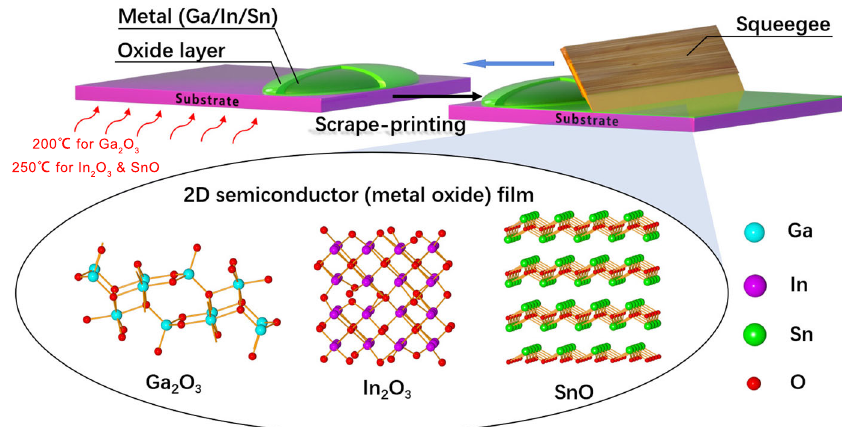
Fig. 1 Schematic of the 2D semiconductors printing process. Liquid metal can form atomic thin-layer metal oxides under atmospheric conditions. When the liquid metal was scraped amongst the surface of the silica layer with the “ squeegee ” , the liquid parent metal is cleared off, however, the layer of oxide adheres to surface of the substrate to achieve a large-scale thin layer of the